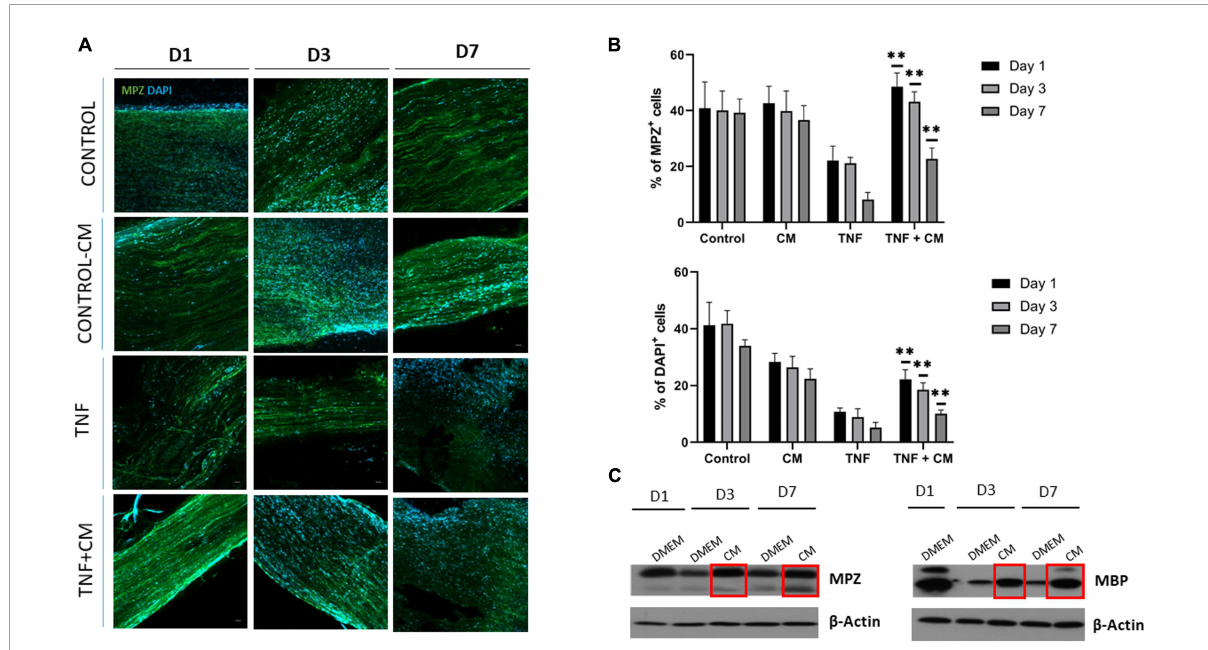
FIGURE5 Sciatic nerves cultured with TNF or TNF and CM ex vivo . (A) Confocal microscopy. Images showing sciatic nerves cultured for 1, 3 and 7 days labeled with the myelin marker MPZ (and DAPI for DNA staining) in control conditions, in the presence of TNF, or TNF+CM. Scale bar: 50 µ m. (B) Histogram comparing the number of cells as a percentage of DAPI-positive nuclei in the cultured nerves and the percentage of green-positive fluorescence representing the myelin protein MPZ ( p ≤ 0.05, ∗∗ p ≤ 0.01 using ANOVA to compare TNF with TNF+CM treated samples). The results are expressed as the mean ± SD of four independent experiments. (C) Western blots showing the levels of myelin proteins MPZ and MBP in sciatic nerves cultured with DMEM and CM for 1, 3 and 7